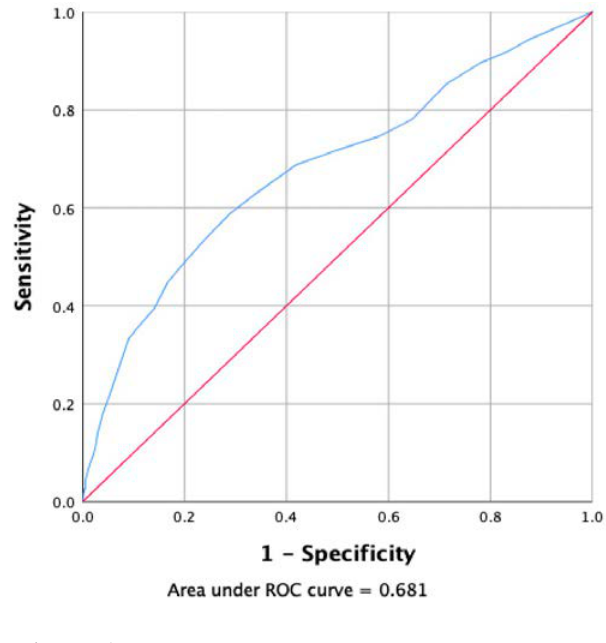
Figure 3. The receiver operator curve (POC) of the C-FCV-19S based on positive-depression.